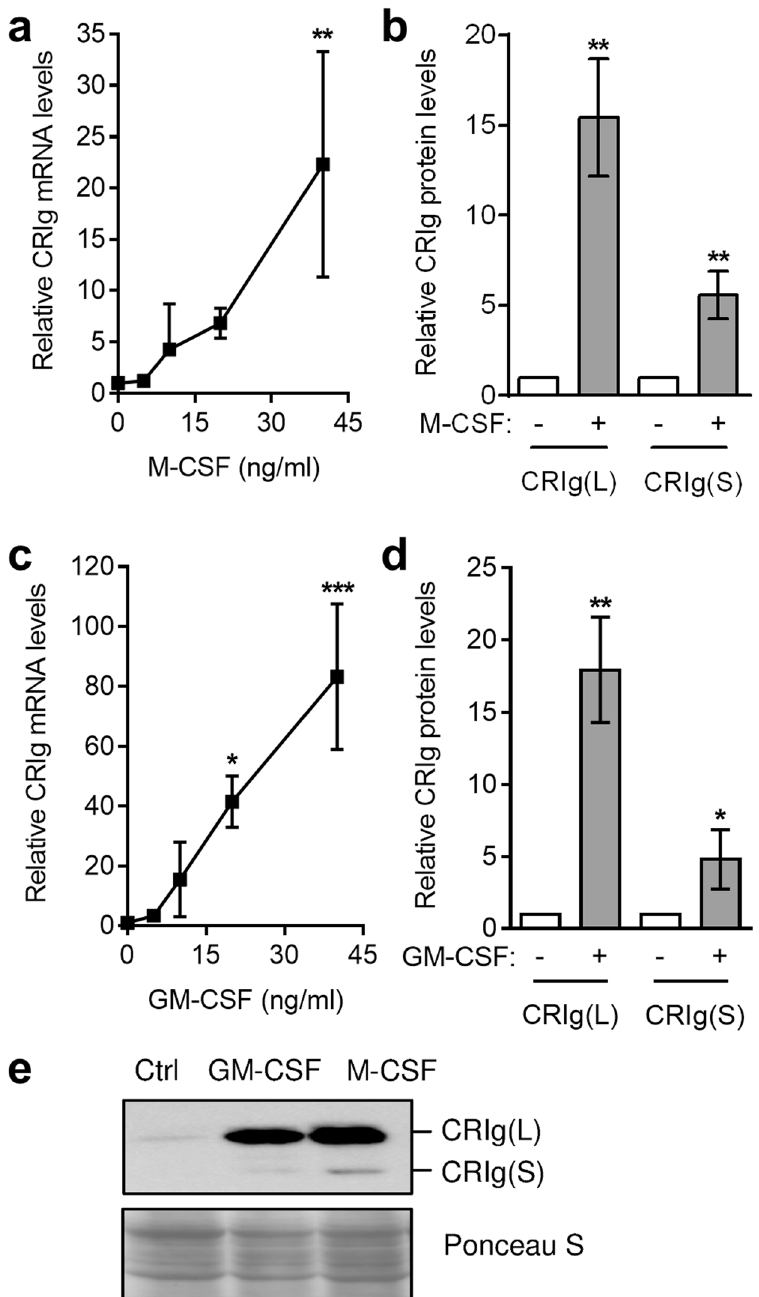
Figure 5. M-CSF and GM-CSF promote the development of CRIg + macrophages. Monocytes were cultured in the presence of 0, 5, 10, 20, 40 ng/ml M-CSF ( a ) or GM-CSF ( c ). Then CRIg mRNA expression measured. For CRIg protein expression monocytes were treated with 40 ng/ml M-CSF ( b ) or GM-CSF ( d ). ( e ) A representative Western blot. Data are presented as means ± SD of three experiments, each conducted with cells from different individuals, * p < 0.05, ** p < 0.01, *** p <